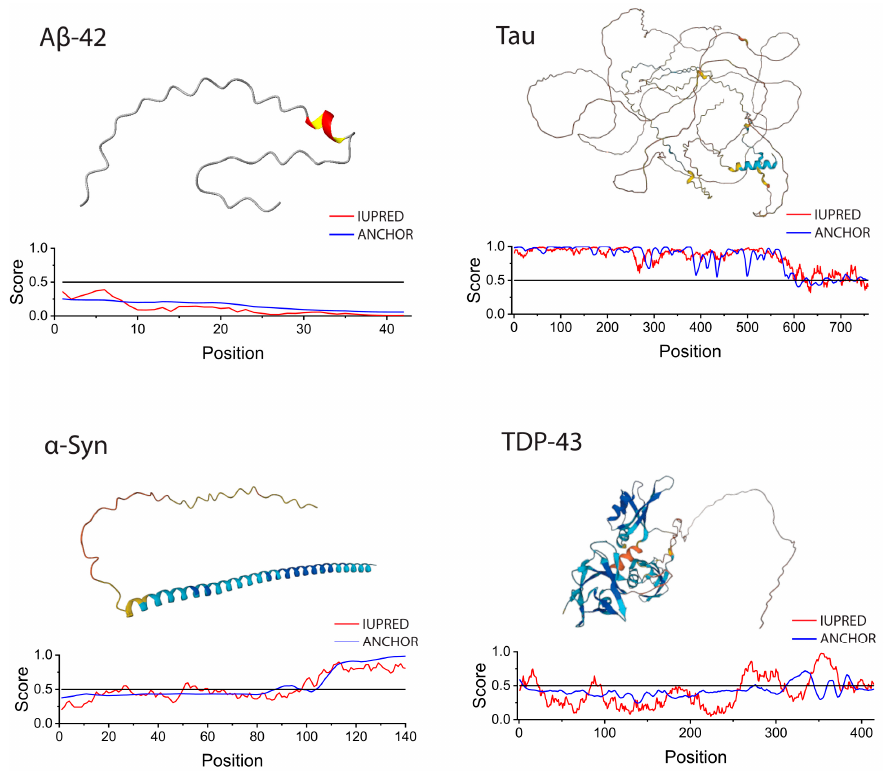
Figure 1. Predicted structure and disorder of A β , tau, α -syn, and TDP-43. Structures were predicted using AlphaFold [26], and calculations for disorder were determined using IUPRED2 [27–30]. IUPRED2 provides IUPred and ANCHOR scores for disordered proteins. ANCHOR predicts disorder based on amino acid sequence, identifying potential binding sites that are disordered in isolation, while IUPred predicts disorder based on energy estimation. IUPred scores from 0 to 0.5 are considered ordered while scores from 0.5 to 1 are considered disordered. A β -42 (human) was chosen as the representative peptide for A β . Tau (human, UniProt ID: P10636) is highly disordered with a C-terminal helical region. α -Syn (human, UniProt ID: P37840) has a disordered C-terminus and α -helical N-terminus. TDP-43 (human, UniProt ID: Q13148) contains a long unstructured C-terminus. (Note that these are predicted structures only and may not represent the major physiological protein conformations. For example, α -syn has been shown to adopt more random coil-like structures in physiological buffer conditions, with the elongated helical structure predicted using AlphaFold only favored in the presence of ligands such as membrane vesicles [31–33]).